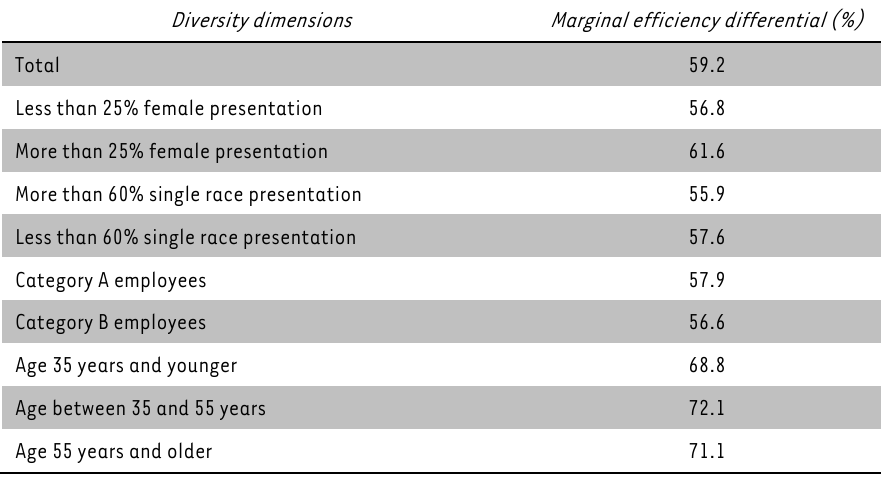
TABLE 2: Marginal efficiency differential for in-house trained employees Diversity